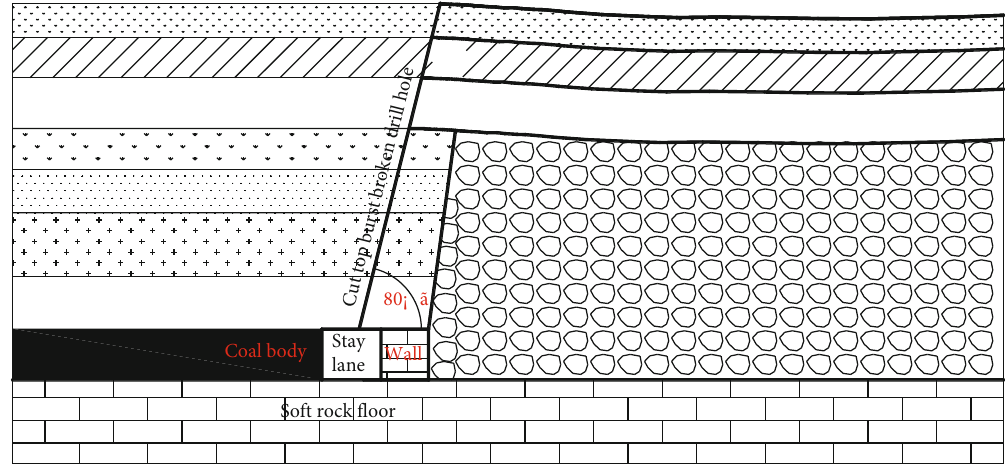
Figure 8: Schematic diagram of the status of the blasting cutting roof active pressure relief and protection